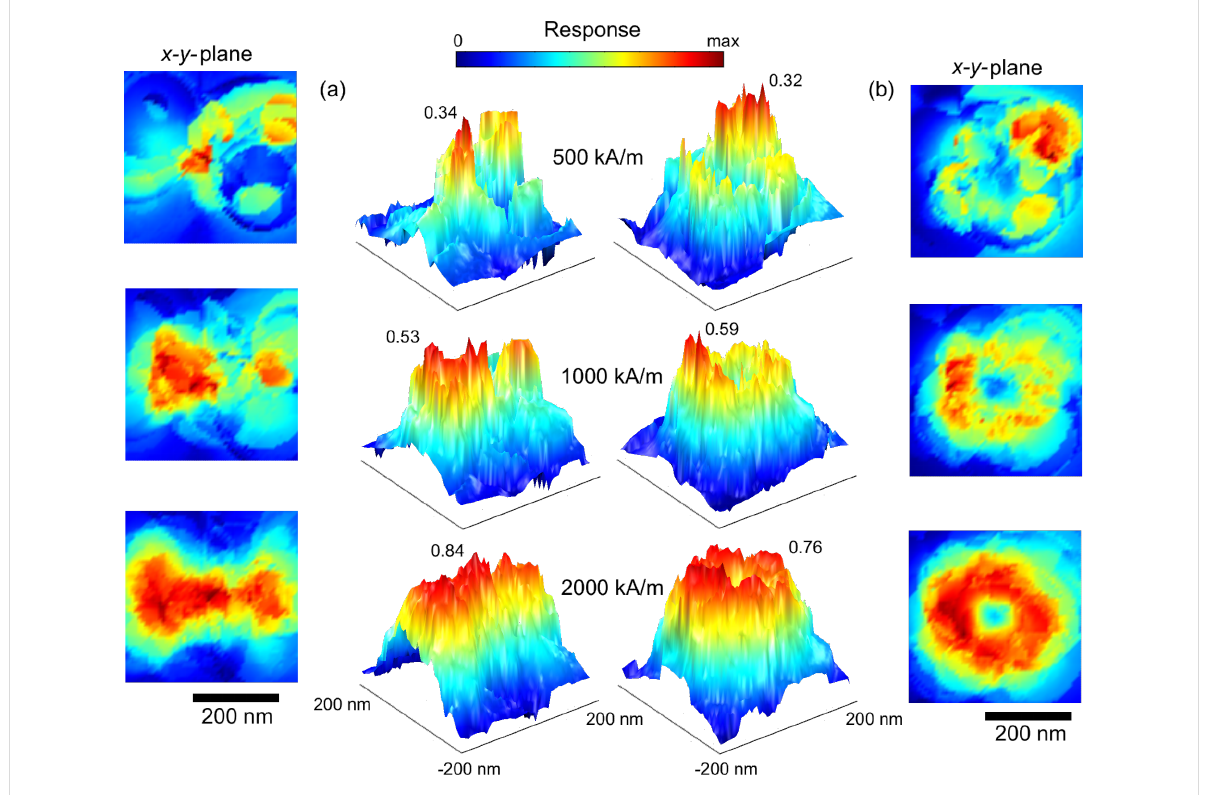
Figure 19: Response maps of a 10 × 10-hexagonal gGMR sensor for a probe particle with R p = 50 nm and M p = 500 (top), 1000 (middle) and 2000 kA/m (bottom); (a) shows the response for m p || and (b) the results for m p ||